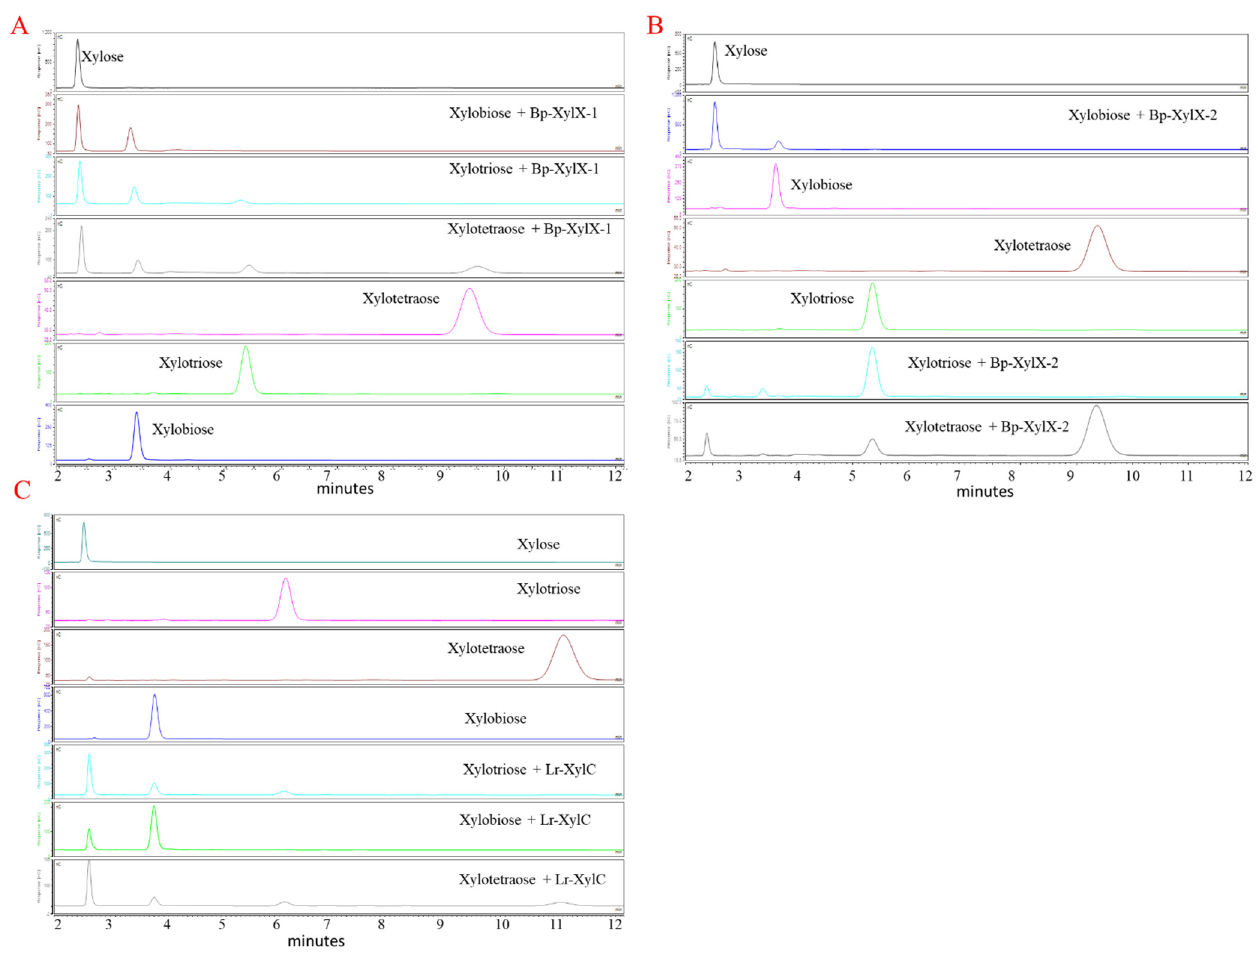
Figure 5. Enzymatic activity of Bp-XylX-1, Bp-XylX-2, and Lr-XylC β -xylosidases on xylobiose, xylotriose, and xylotetraose. The reaction was carried out at 37 °C for 15 min, and the products of digestion by Bp-XylX-1 ( A ), Bp-XylX-2 ( B ), and Lr-XylC ( C ) were determined by HPAEC-ED. An isocratic gradient of 200 mM NaOH was used in A and B, while 150 mM was used for C.